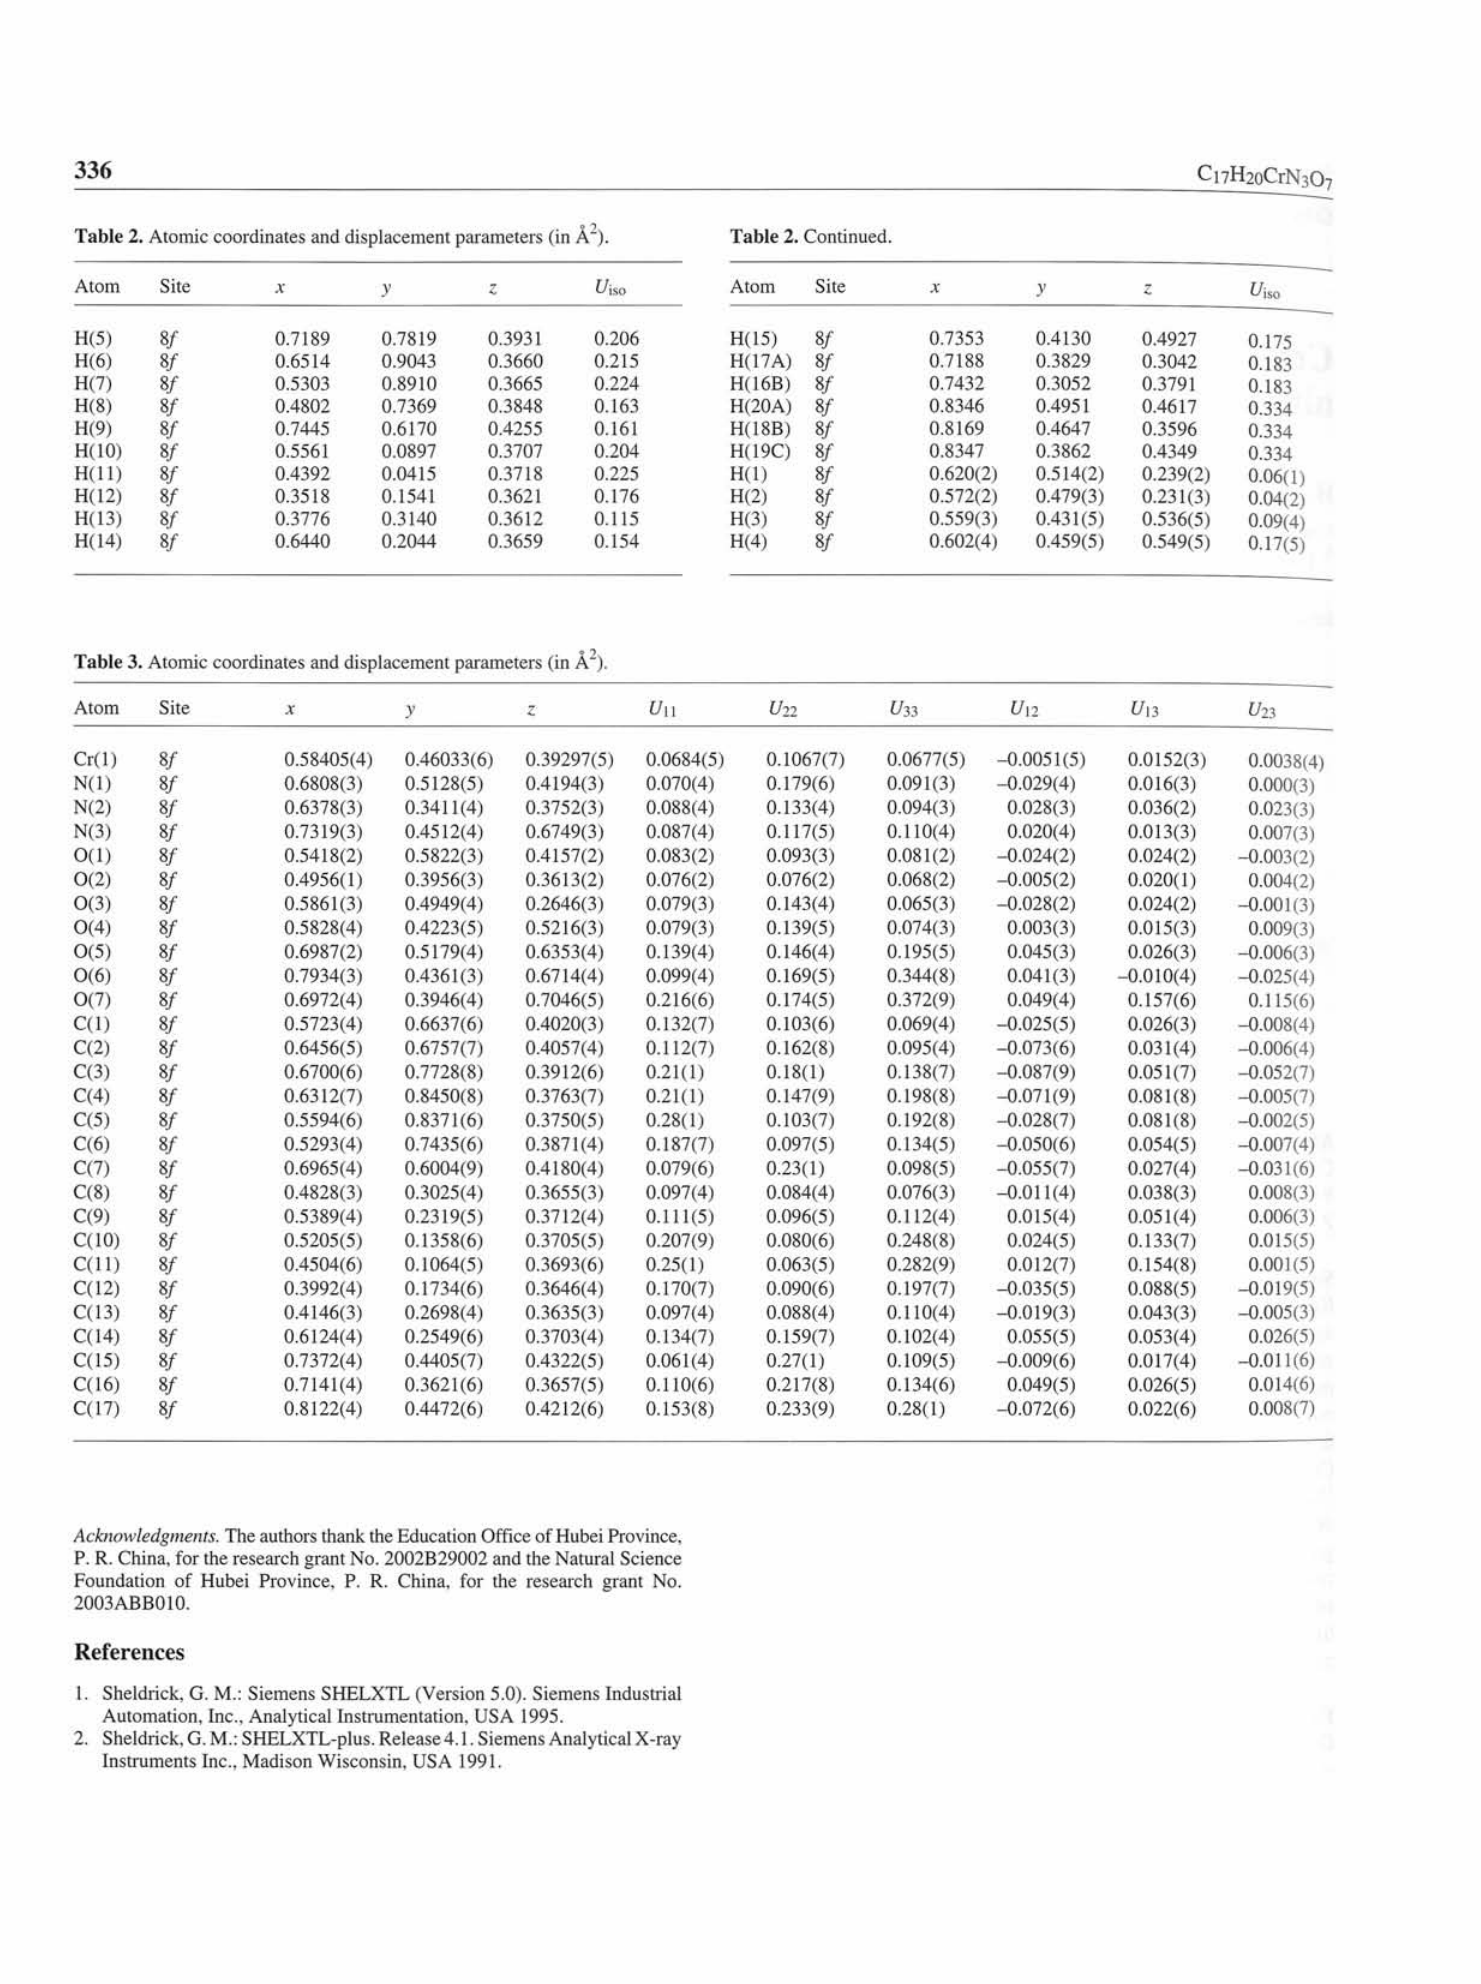
Table 2. Atomic coordinates and displacement parameters (in À 2 ). Table 2. Continued.